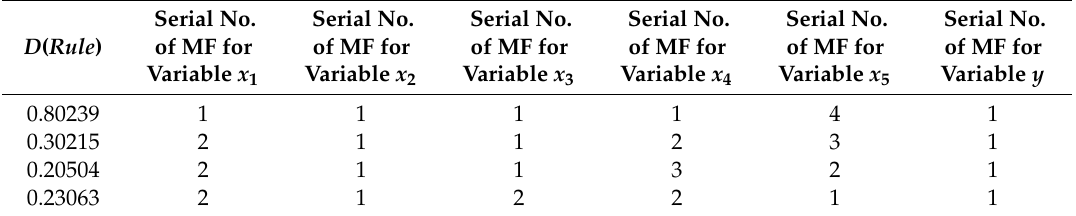
Table A1. The fuzzy rules obtained from the empirical data in the case of joint speed and space capabilities